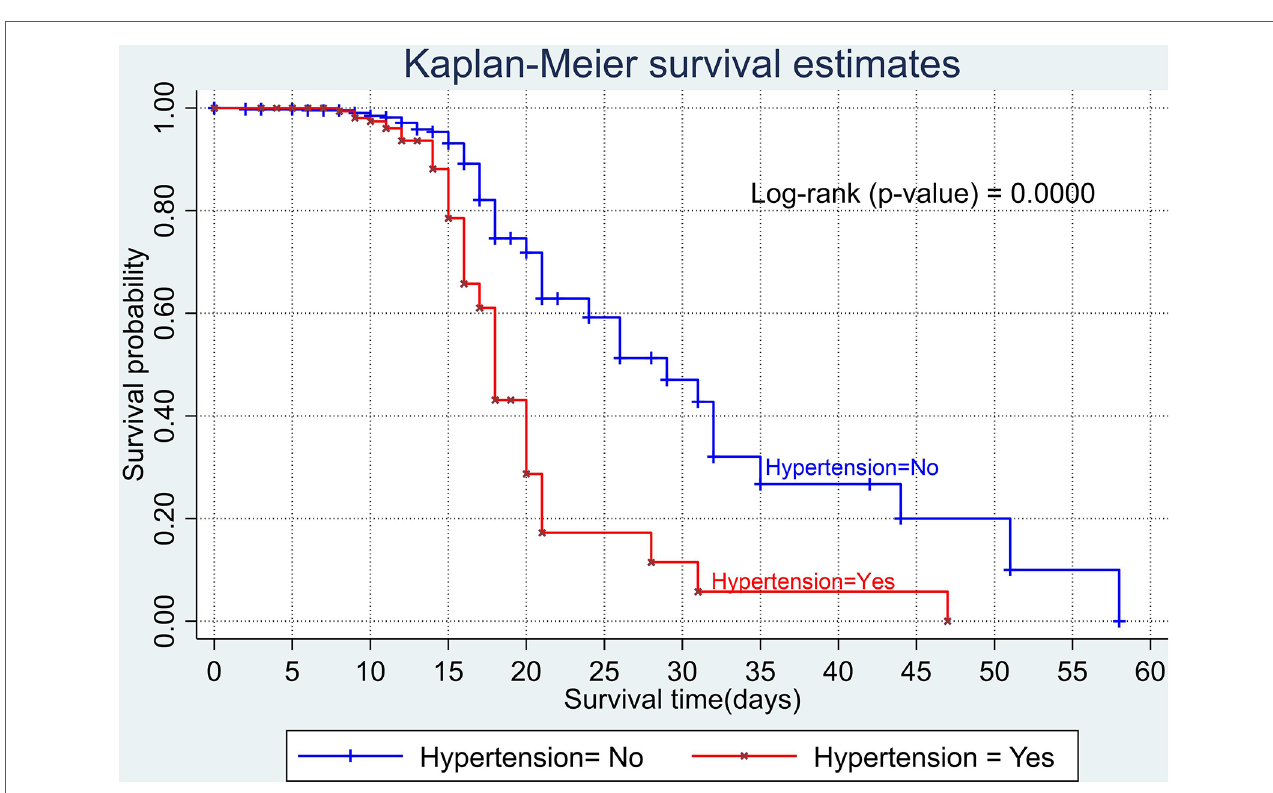
FIGURE 6 Kaplan – Meier survival curve based on the presence of hypertension among adult COVID-19